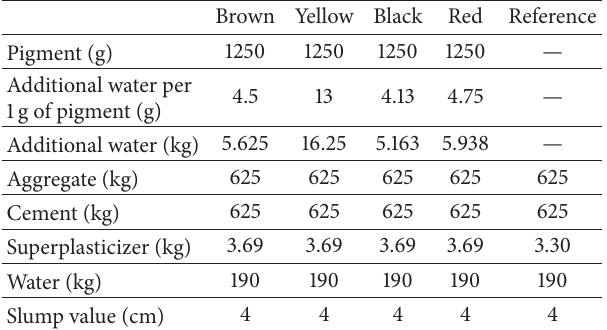
Table 4: Material content of 1m 3 mortar